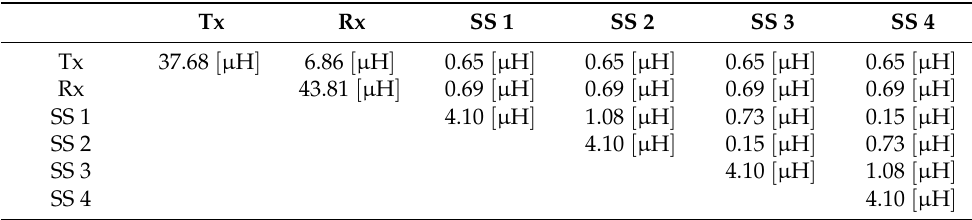
Table 2. Electrical parameters (Inductance).